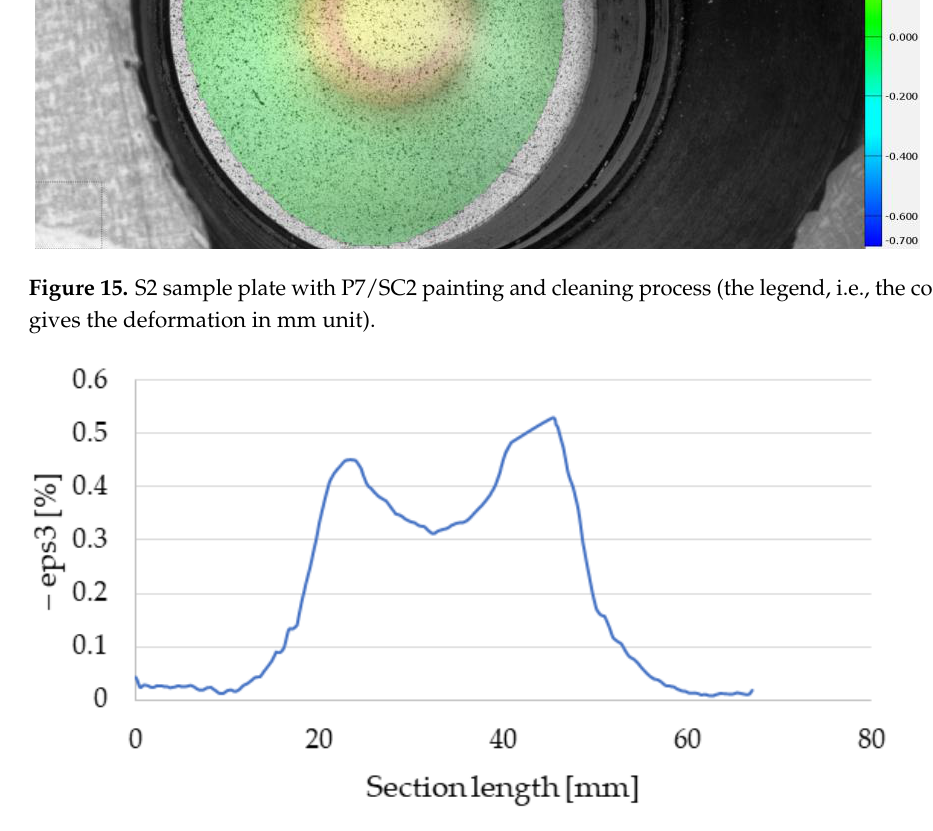
Table 11. Thickness reduction results measured at the apex of the test specimen using different painting/cleaning procedures. ID.